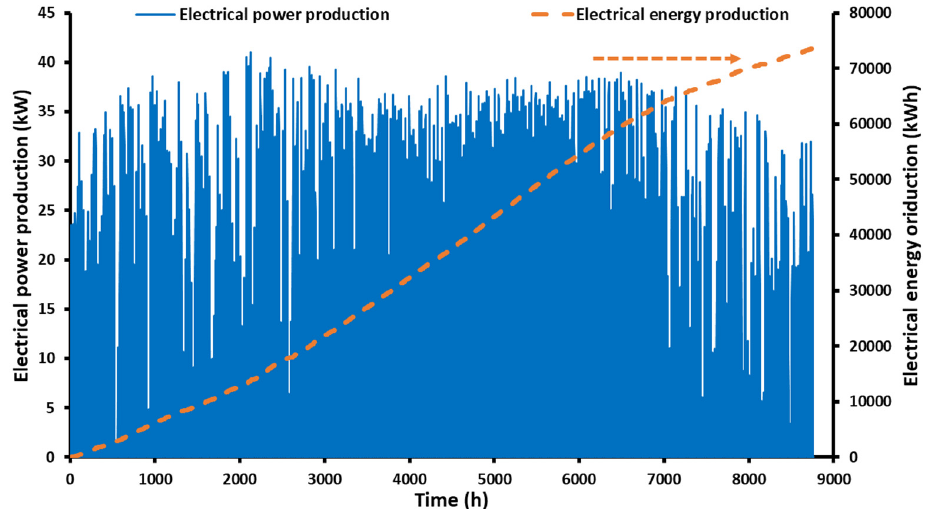
Figure 10. Variation in the produced electricity from the photovoltaics in [kW] and the cumulative electricity production in [kWh].